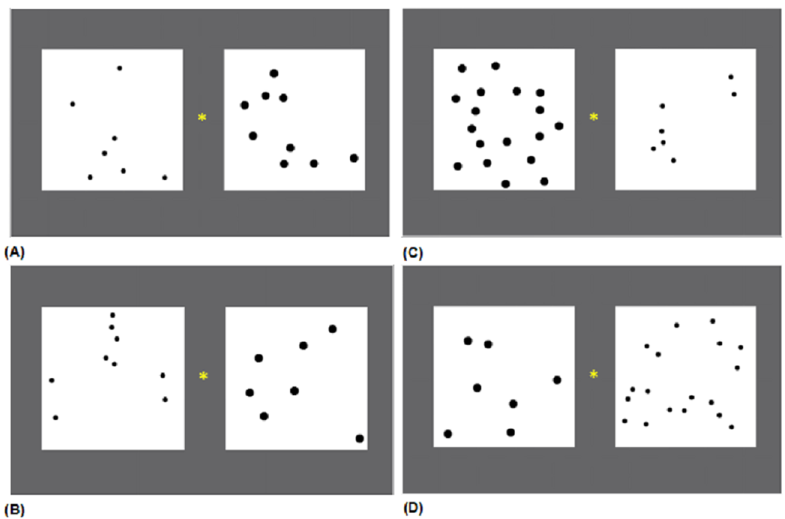
Fig 1. Examples of stimuli presented in a non-symbolic physical size comparisons task. A. Congruent pair, 7 vs. 9 dots (high ratio), both numericallyand physicallylarger comparedwith numerically and physically smaller dots which togetherhave a smaller total surface area. B. Incongruentpair, 7 vs. 9 dots (high ratio), numerically larger but physicallysmaller dots compared with numerically smaller but physicallylarger dots which together have a larger total surface area. C. Congruent pair, 7 vs. 18 dots (low ratio). D. Incongruent pair, 7 vs. 18 dots (low ratio).